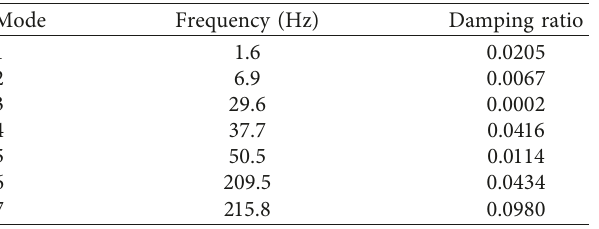
Table 6: Torsional vibration modal frequency.